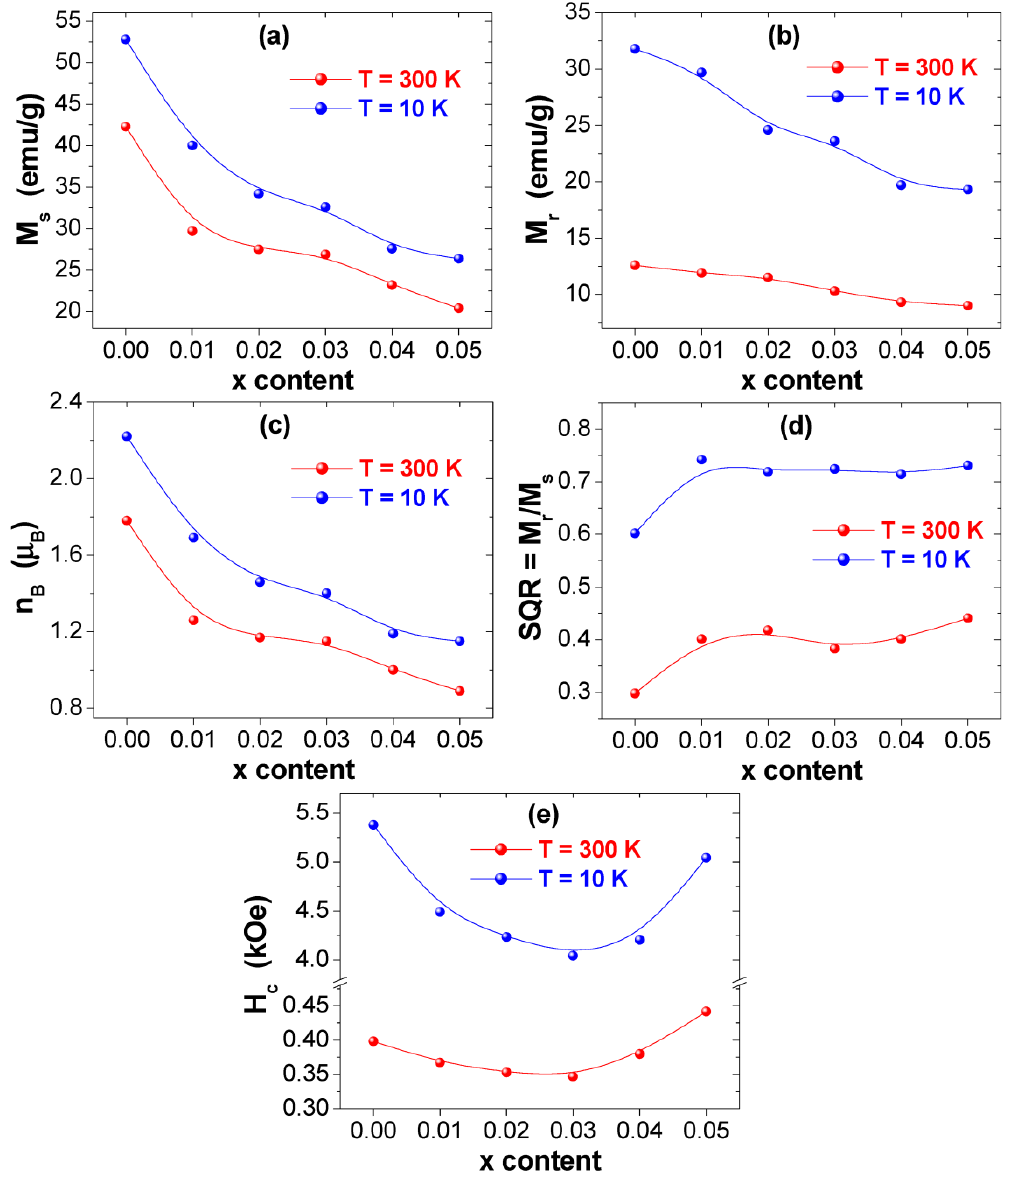
Figure 7. Variations of various deduced magnetic parameters of (Co 0.5 Ni 0.5 )[Tm x Tb x Fe 2−2x ]O 4 with x = 0.00–0.05) NSFs at T = 300 and 10 K: ( a ) M s , ( b ) M r , ( c ) 𝑛 𝐵 , ( d ) SQR = M r /M s , ( e ) H c . x = 0.00–0.05) NSFs at T = 300 and 10 K: ( a ) M s , ( b ) M r , ( c ) n B , ( d ) SQR = M r / M s , ( e ) H c